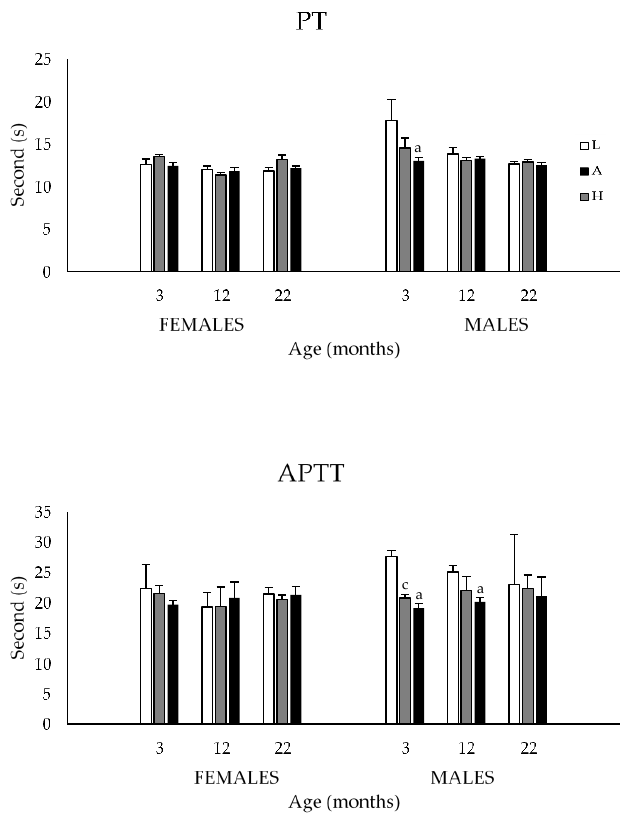
Figure 3. Prothrombin (PT) and activated partial thromboplastin (APTT) times of 3-, 12-, and 22-month-old M and F Sprague–Dawley rats fed the L, A or H diets throughout their lives. The 3-way ANOVA revealed no main sex and age effects for either variables. In contrast, a diet effect was observed in M rats fed the L diet. Specifically, this diet was associated with increased PT at 3 months and increased APTT at 3 and 12 months; a : p < 0.05 between H and L group same age and sex; c : p < 0.05 between A and L group same age and sex (one-way ANOVA). Values are expressed as mean ± SEM; n = 4–7/sex/age/diet groups.